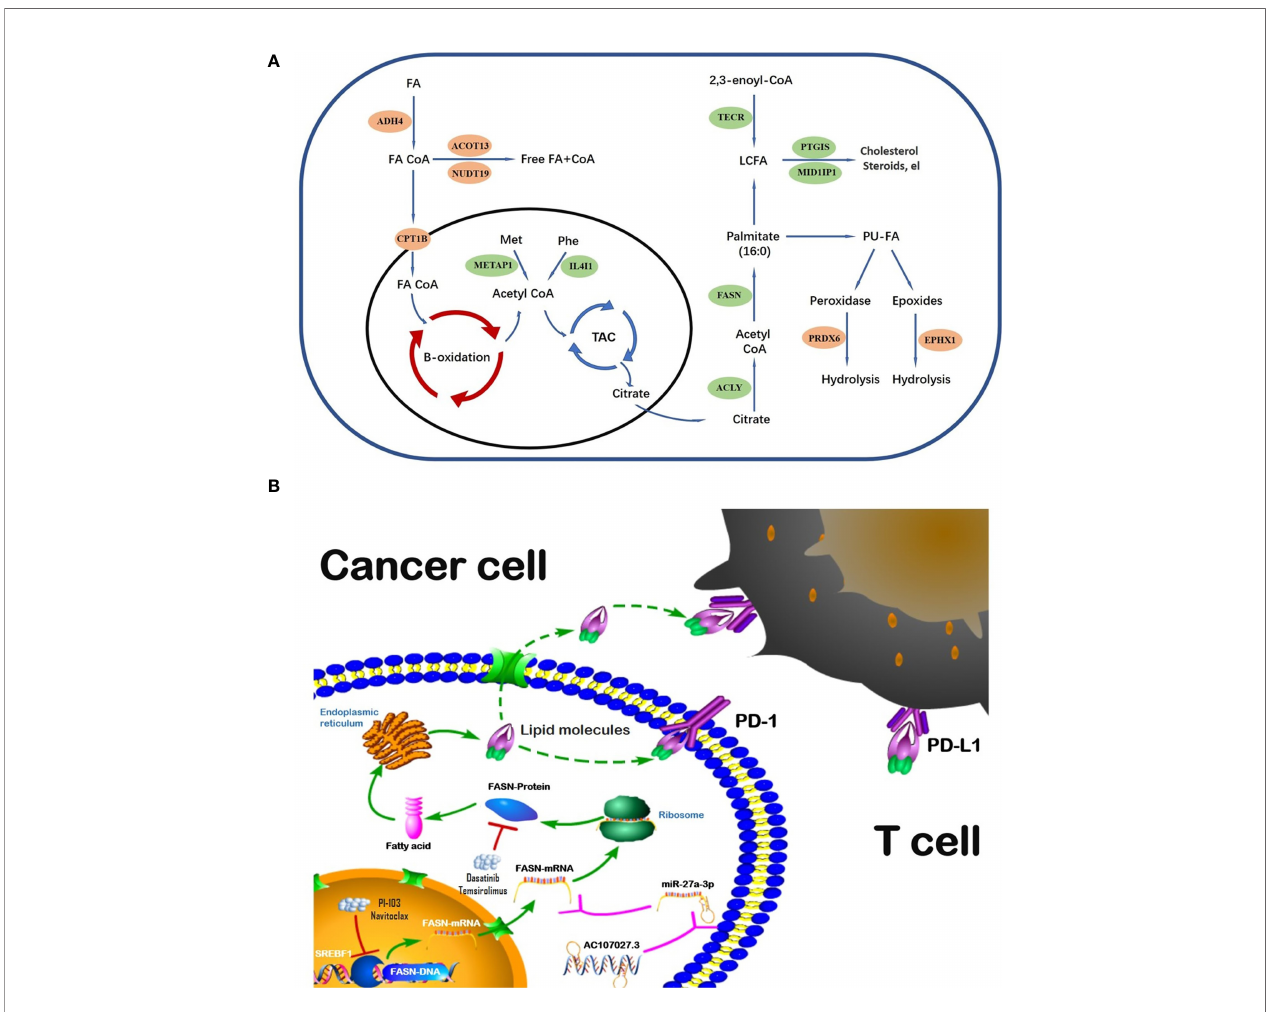
FIGURE 8 | Schematic diagram of FAM genes (A) and FASN regulation (B)